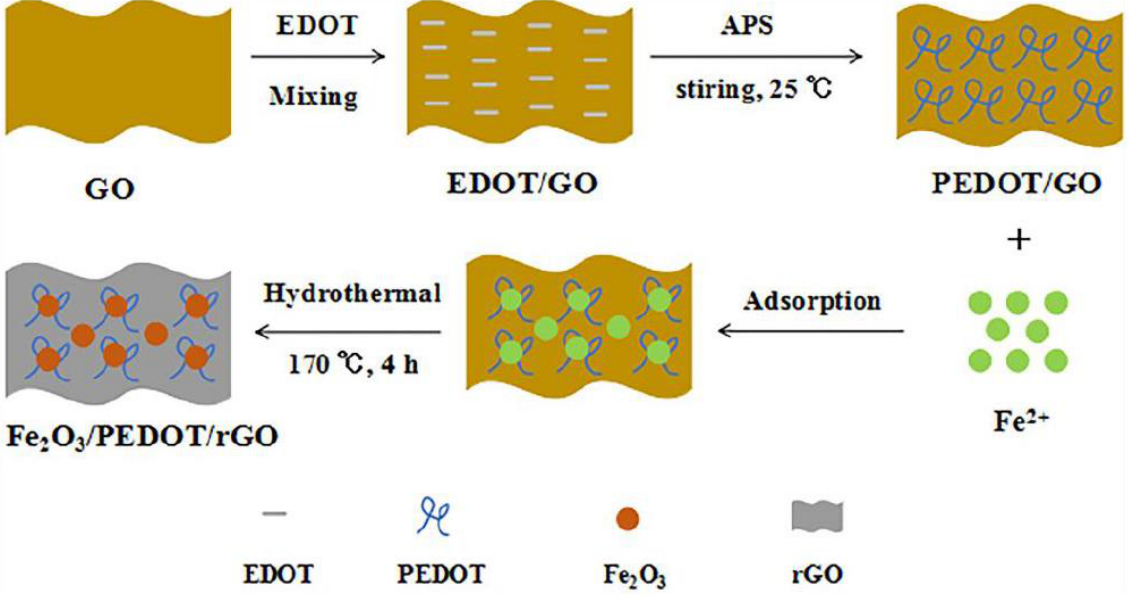
Figure 2. Schematic illustration for the preparation of Fe 2 O 3 /PEDOT/rGO composite. Reprinted from [43].